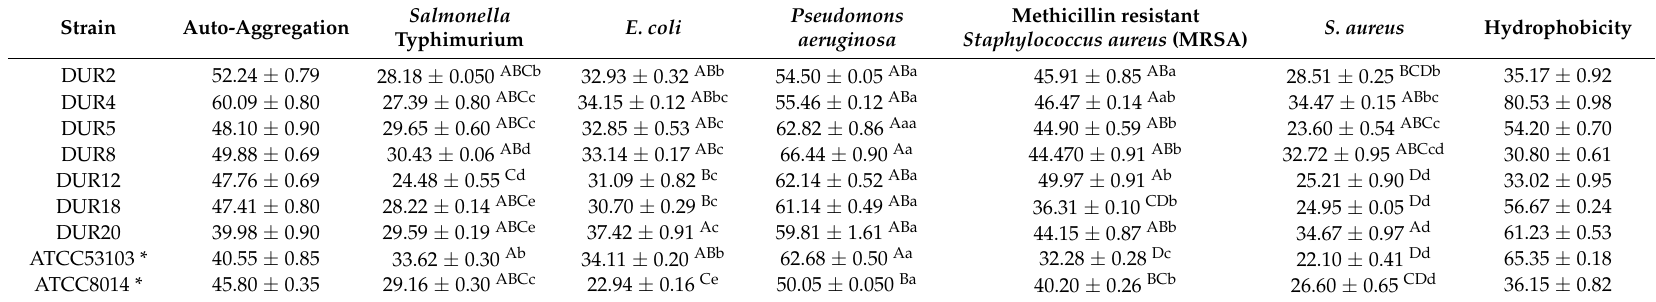
Table 4. Auto-aggregation, co-aggregation ability of the Lactobacillus strains with five pathogenic bacteria, and hydrophobicity 1 .